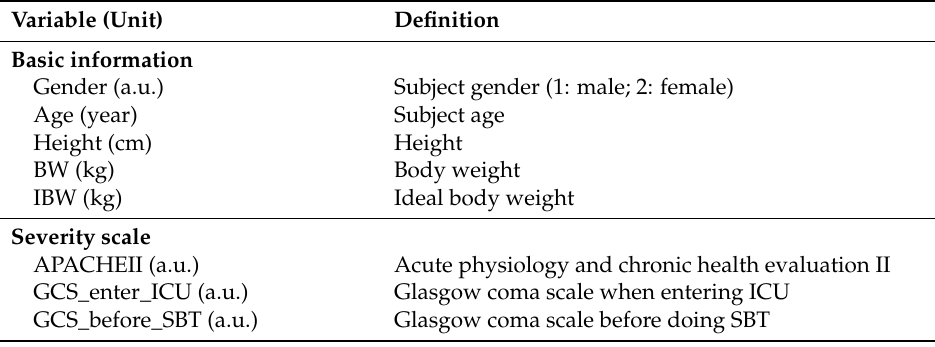
Table 1. Selected clinical variables.